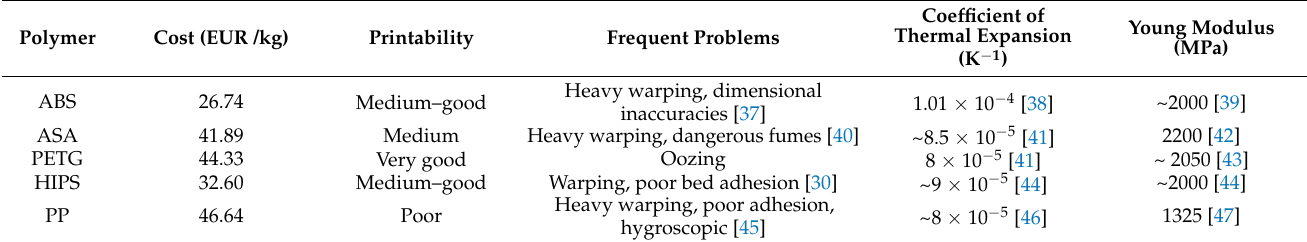
Table 3. Cost, printability, and relevant mechanical properties of polymers.